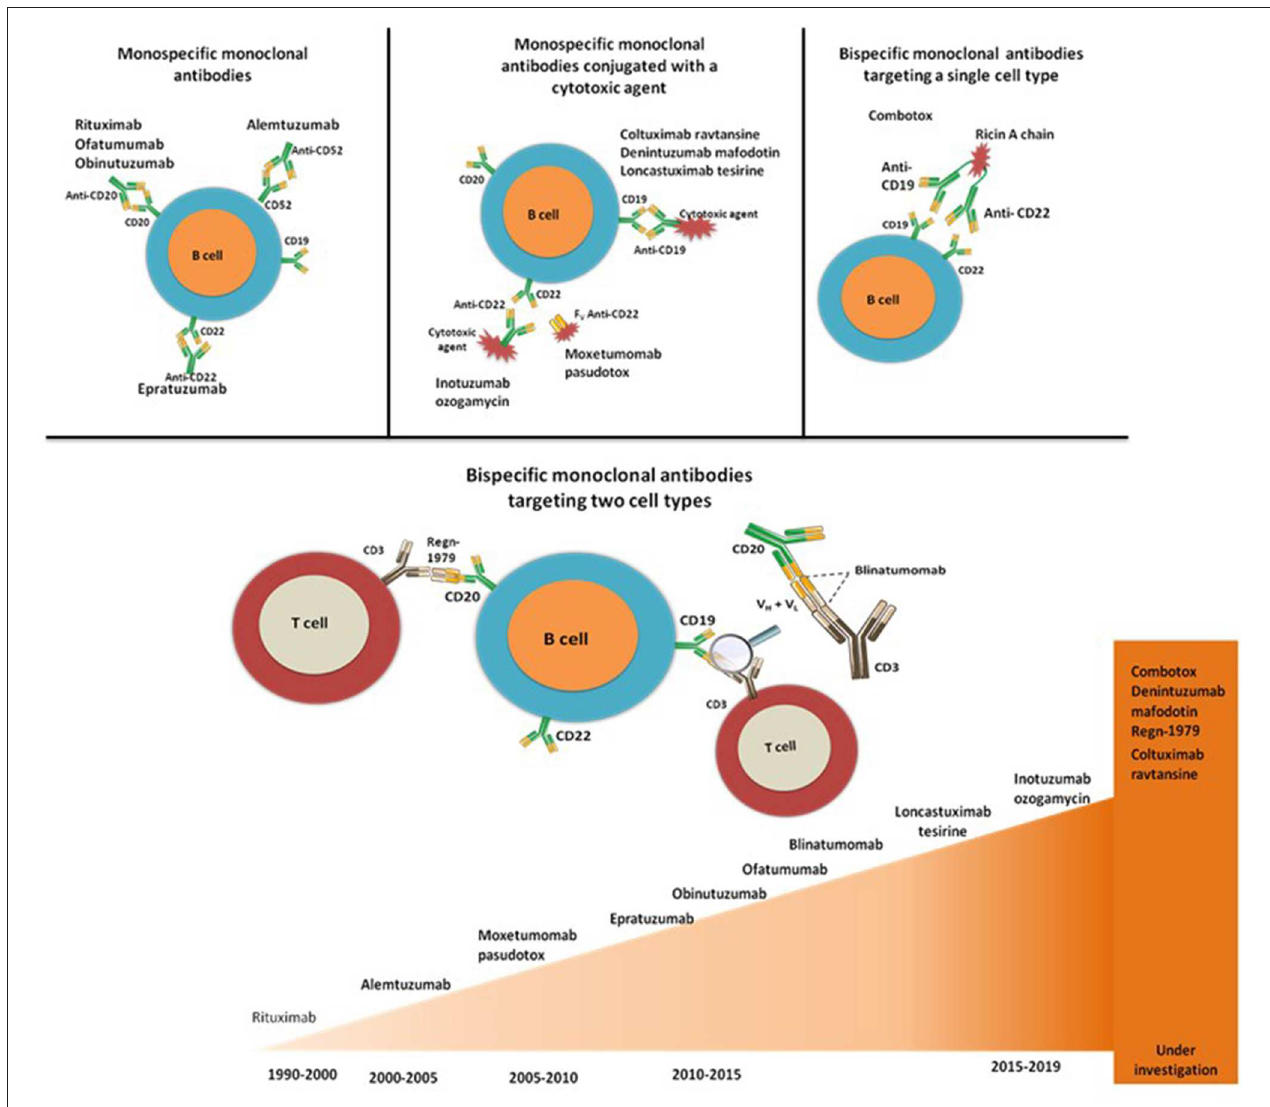
FIGURE 1 | Evolution of monoclonal antibody-based for B-cell